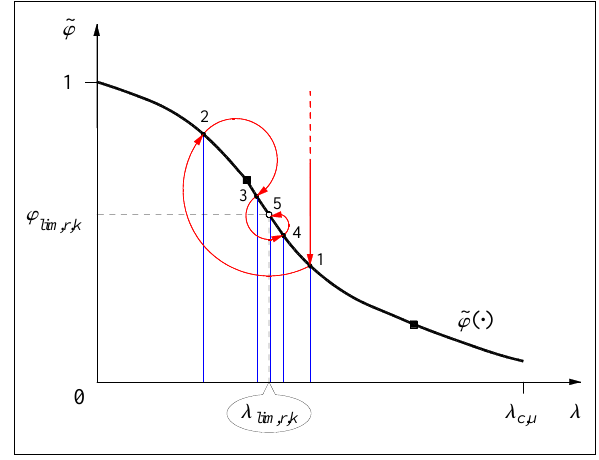
Fig. 11. Binary search algorithm for defining limit slenderness ratio λ lim,r,k of LINK11 element